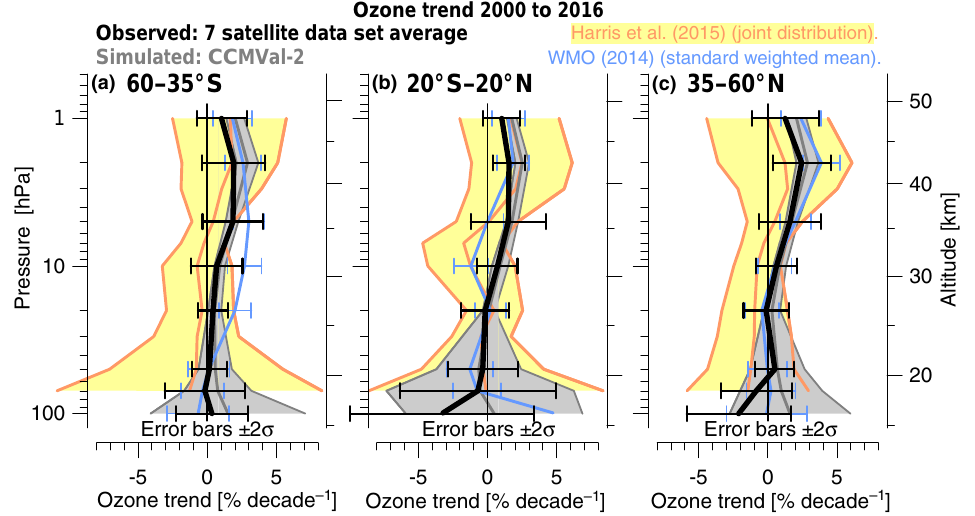
Figure 5. Same as Fig. 4, but giving the average 2000 to 2016 ozone trends (black lines) from seven merged satellite data sets (GOZCARDS, SWOOSH, SAGE–OSIRIS, SAGE–CCI–OMPS(2D), SAGE–MIPAS–OMPS(v2), SBUV-NASA, and SBUV-NOAA). SBUV trends are only used at levels above 40hPa (23km). For comparison, the 1998 to 2012 average ozone trend from Harris et al. (2015, yellow lines and shading), and the 2000 to 2013 average ozone trend from WMO 2014 (blue lines) are shown as well. In all cases, uncertainty bars or shading give ± 2 σ uncertainty. For the 2000 to 2016 satellite average ozone trends (black error bars), and trends from Harris et al. (2015, yellow shading) the uncertainty is derived from the SD σ between individual trends in the average (joint distribution case). For the WMO 2014 trends (blue error bars), the uncertainty of the standard weighted mean is given (see text for details). Grey lines and shading give the trend and ± 2 σ uncertainty obtained from multimodel mean and SD of the CCMVal-2 model simulations (see text in Sect.